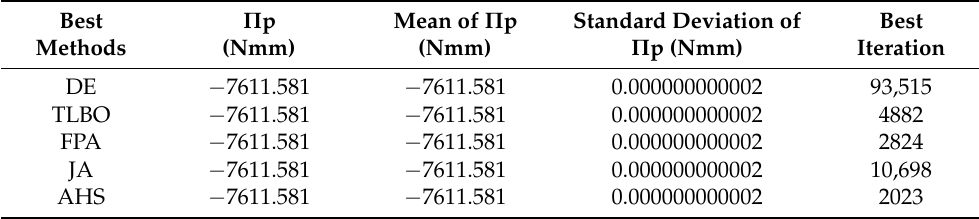
Table 2. Evaluation of best iteration steps among maximum iteration numbers to reach the minimum total